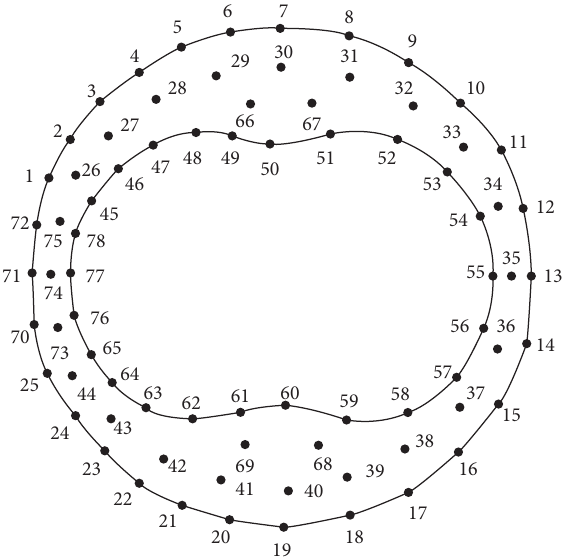
Figure 10: Layout of the measurement points for a closed